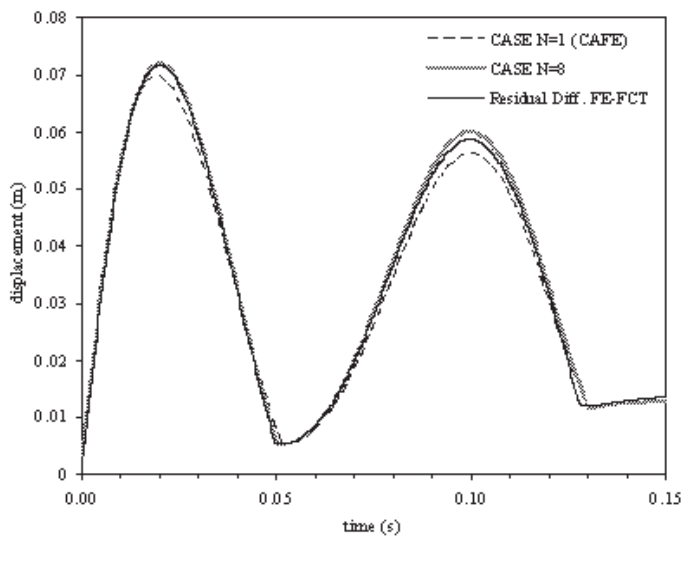
Fig. 10. Results for the displacement of m 1 using 81 fluid